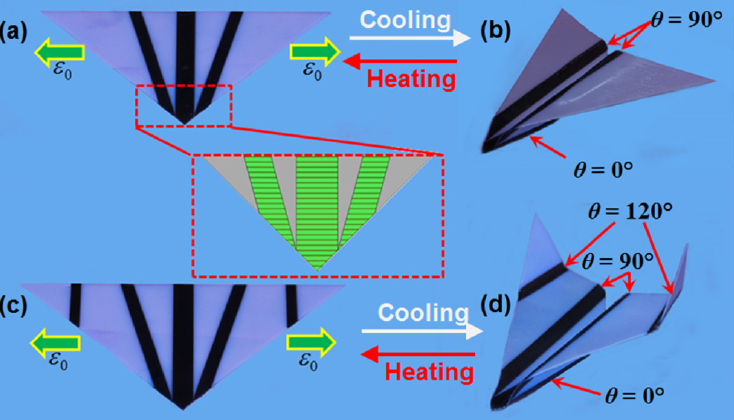
Figure 13. Origami airplanes produced by active 4D printing concept [78]. A flat triangle polymer sheet with three hinges in ( a ) assembles itself into an origami airplane with a 0° angle in the middle hinge that bends upward having 90° angles in the two side hinges being bend downward in ( b ). Furthermore, a flat triangle sheet with five hinges in ( c ) assembles itself into an origami airplane with two winglets as presented in ( d